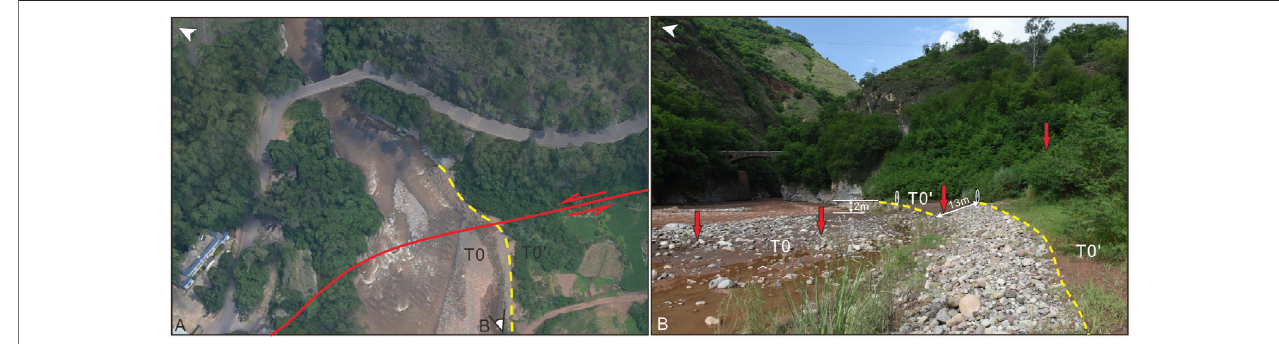
FIGURE 12 | (A) Air photo of the displacement of the Heishui River fl oodplain (see the location in Figure 3 ); (B) fi eld view of the displacement of the Heishui River fl oodplain.